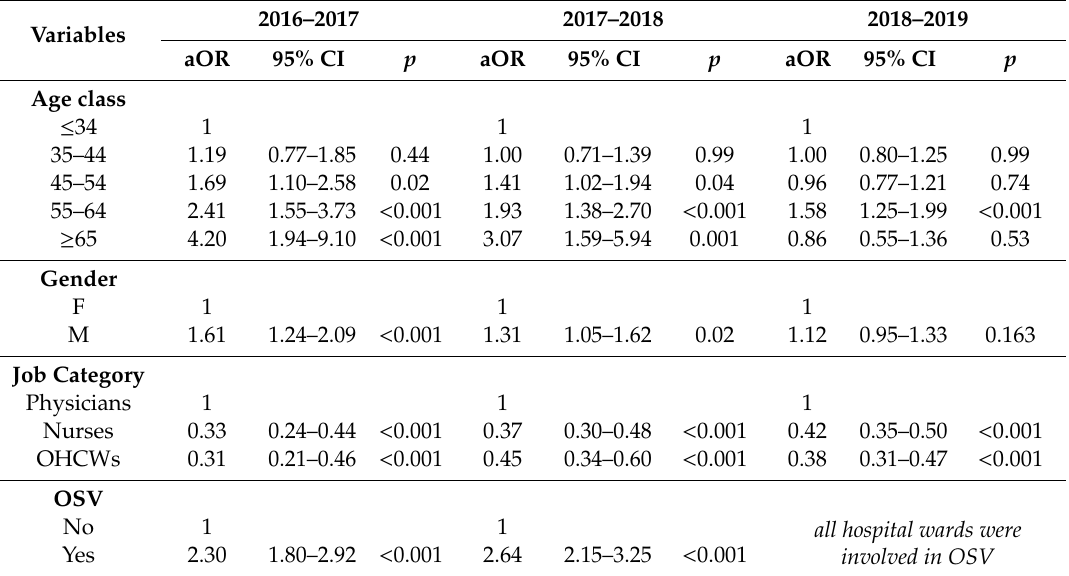
Table 3. Logistic regression (one for each flu vaccination campaign). Vaccination (yes / no) during the relative influenza season is the dependent